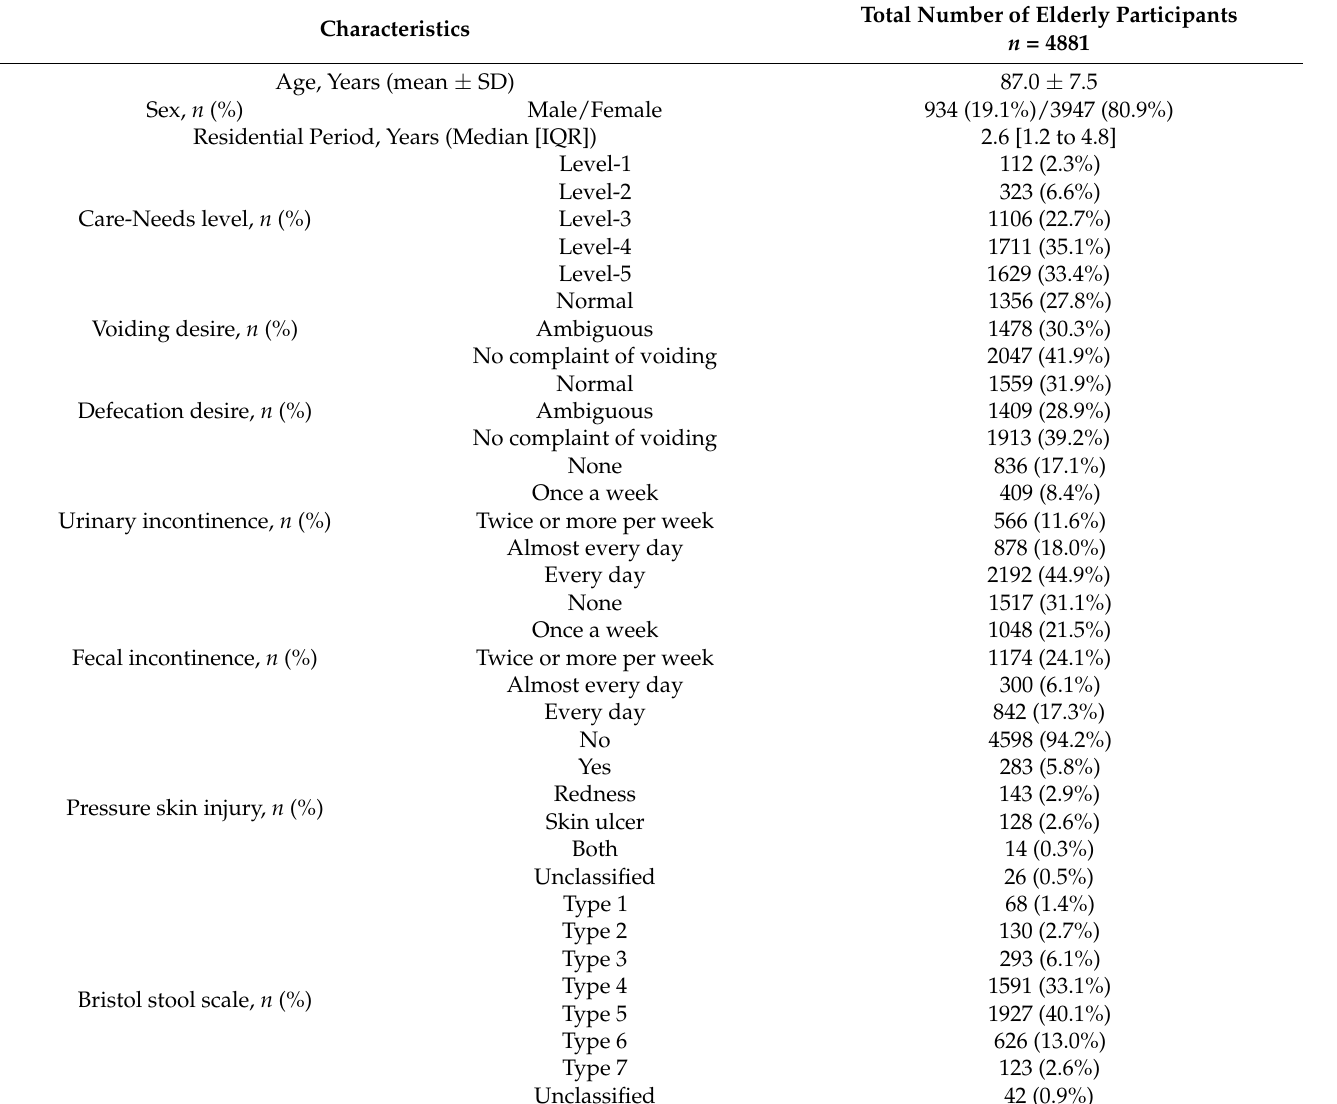
Table 1. Baseline characteristics of the elderly